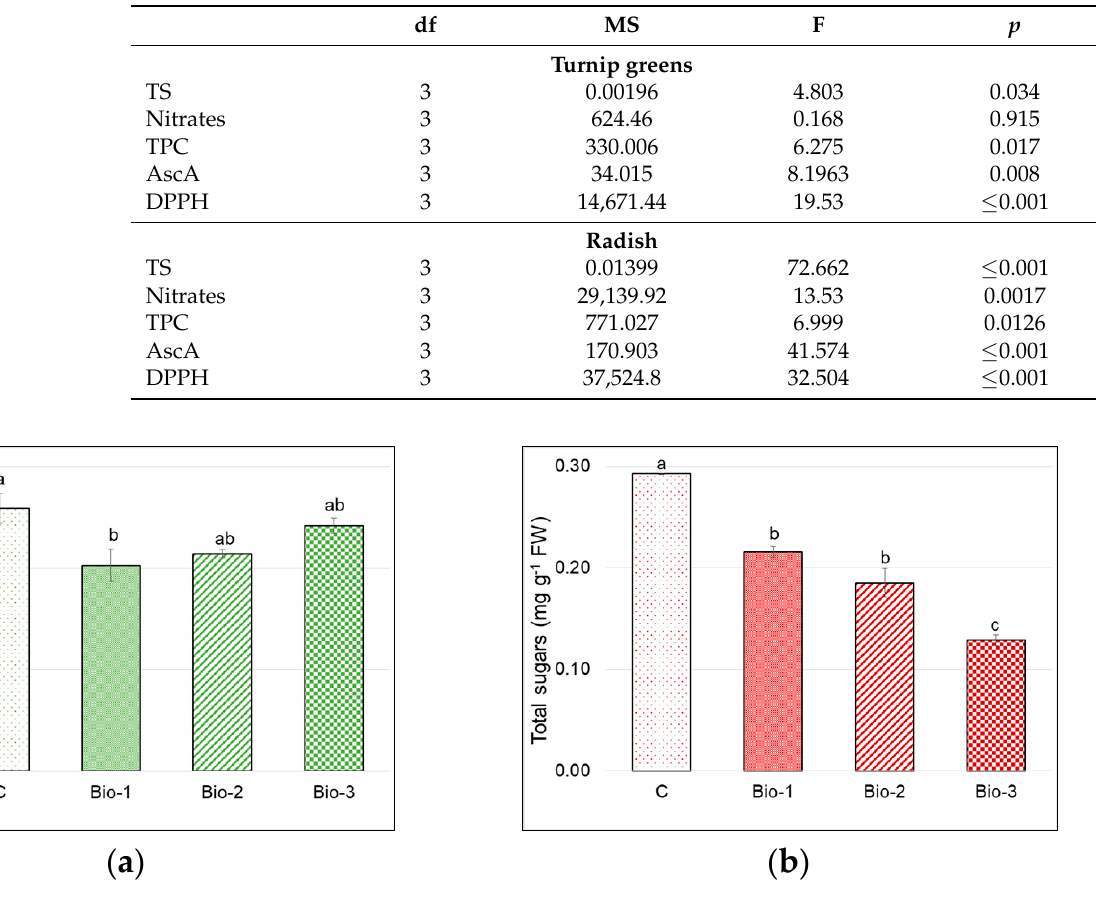
Figure 3. Effect of biostimulants (Bio-1 = TRAINER ® ; Bio-2 = AQUAMIN, and Bio-3 = Moringa oleifera leaf extract) on the total sugars (mg g − 1 FW) in in turnip greens ( a ) and radish ( b ). Data are means ± se ( n = 3). Different letters indicate significance at p ≤ 0.05 according to the LSD test. Table 4. Results of one-way ANOVA for total sugars (TS) and nitrates content, total phenolic content (TPC), ascorbic acid (AscA), and antioxidant activity (DPPH), in microgreens of turnip greens and radishes.